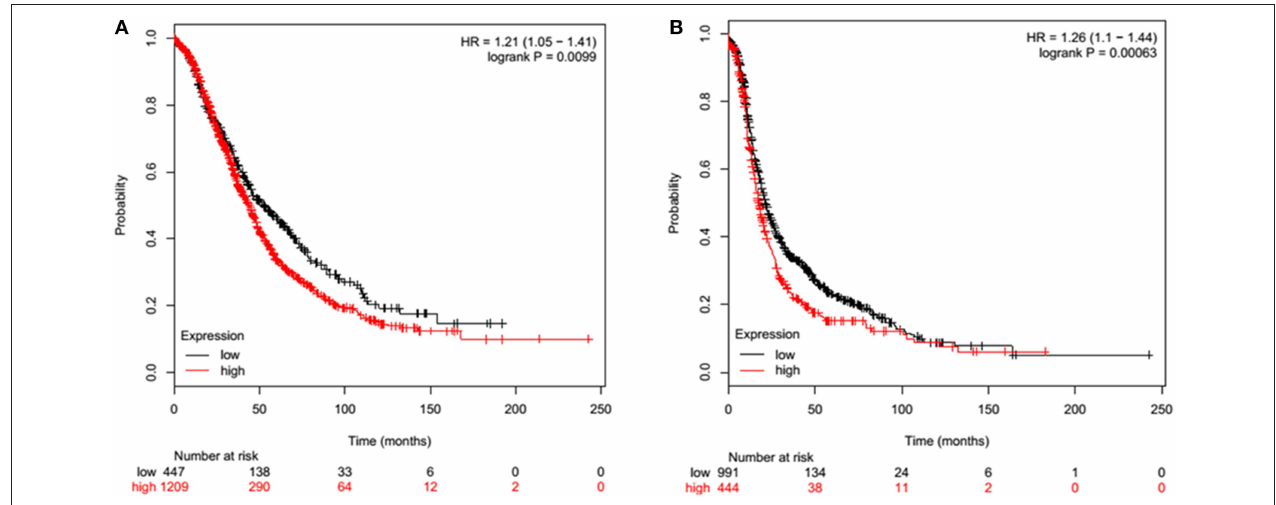
FIGURE 2 | Overall Survival (OS) of ovarian cancer patients expressing high (red) and low (black) SP-D (A) . High ( n = 1209) and low ( n = 447) expression of SP-D is shown over a 250 month (20 year) period. Low SP-D expression shows a significant improvement in survival than high SP-D expression ( p = 0.0099). Progression-Free Survival (PFS) of ovarian cancer patients expressing high (red) and low (black) SP-D (B) . High ( n = 444) and low ( n = 991) expression of SP-D is shown over a 250 month (20 year) period. There is greater overall survival in low SP-D expression compared to high SP-D expression ( p = 0.00063).